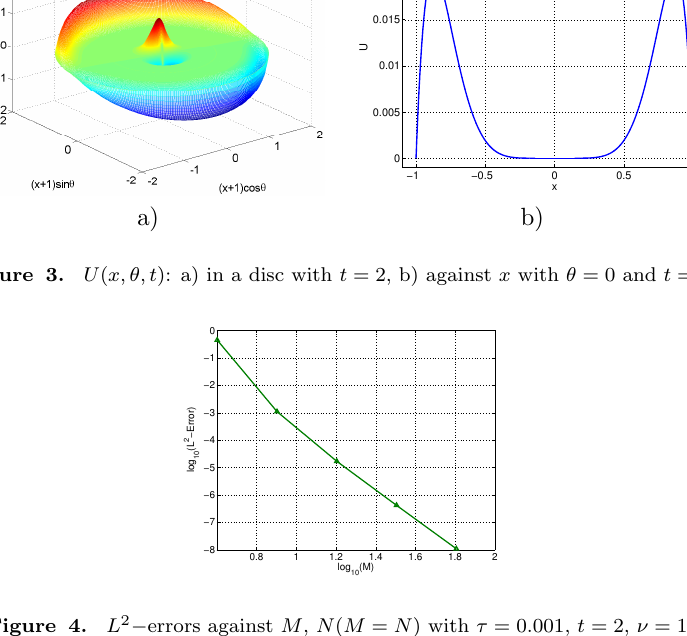
Figure 4. L 2 − errors against M , N ( M = N ) with τ = 0 . 001 , t = 2, ν =